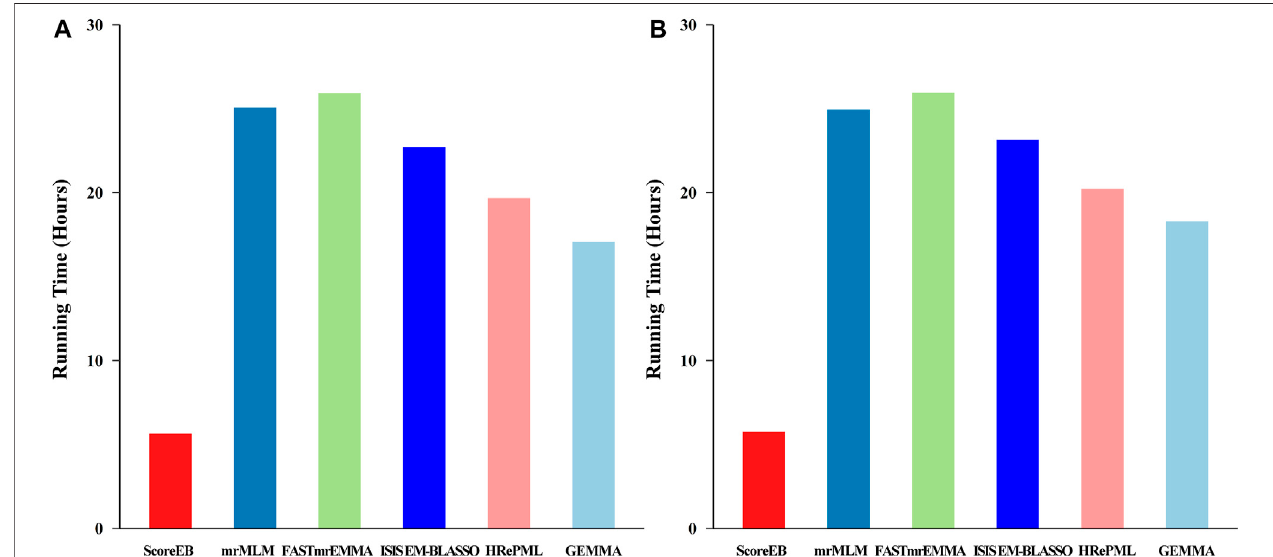
FIGURE 4 | Comparison of 1,000 replicates running time using six methods (ScoreEB, mrMLM, FASTmrEMMA, ISIS EM-BLASSO, HRePML and GEMMA) in simulation 1 (A) and simulation 2 (B)